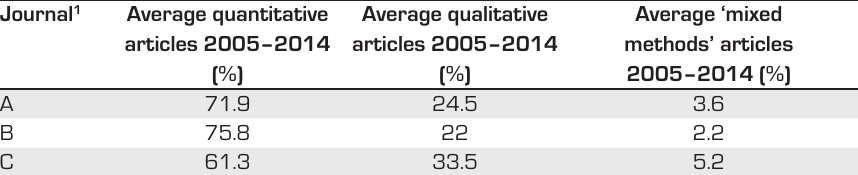
TABLE 1: Quantitative and qualitative publication ratio in selected South African management